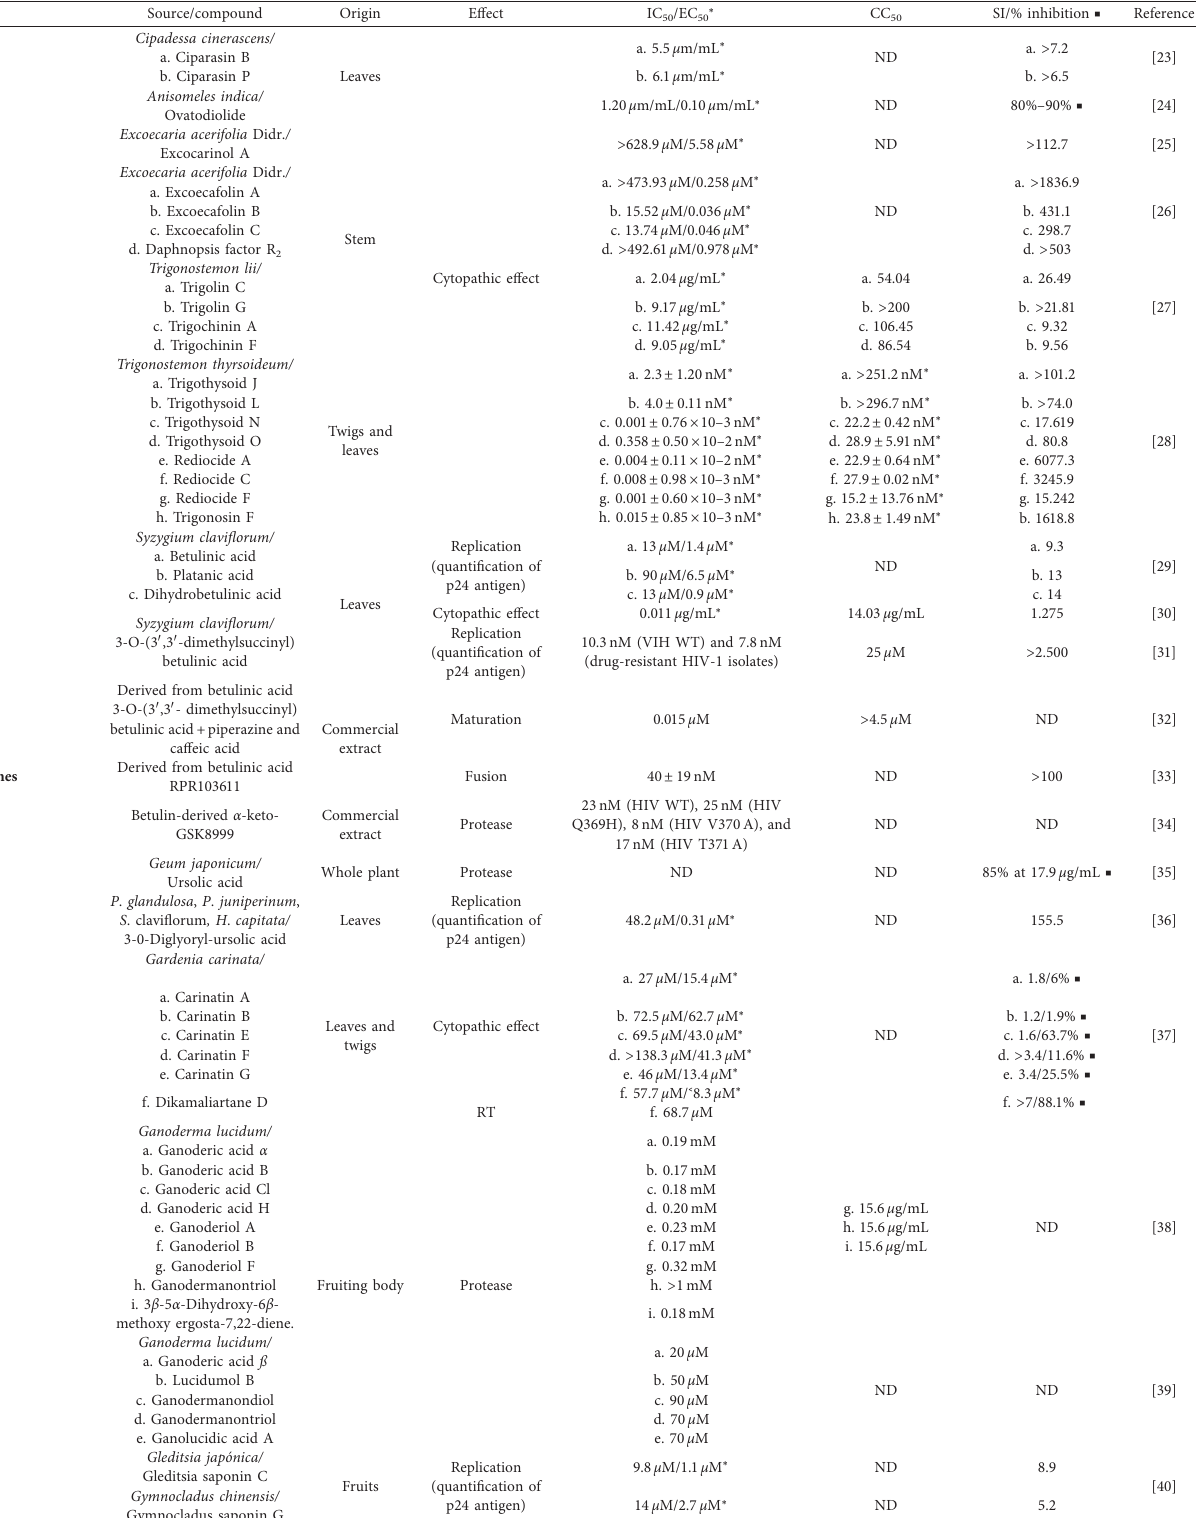
Table 1: Natural compounds with anti-HIV-1 activity extracted from fungi, plants, or marine sponges.